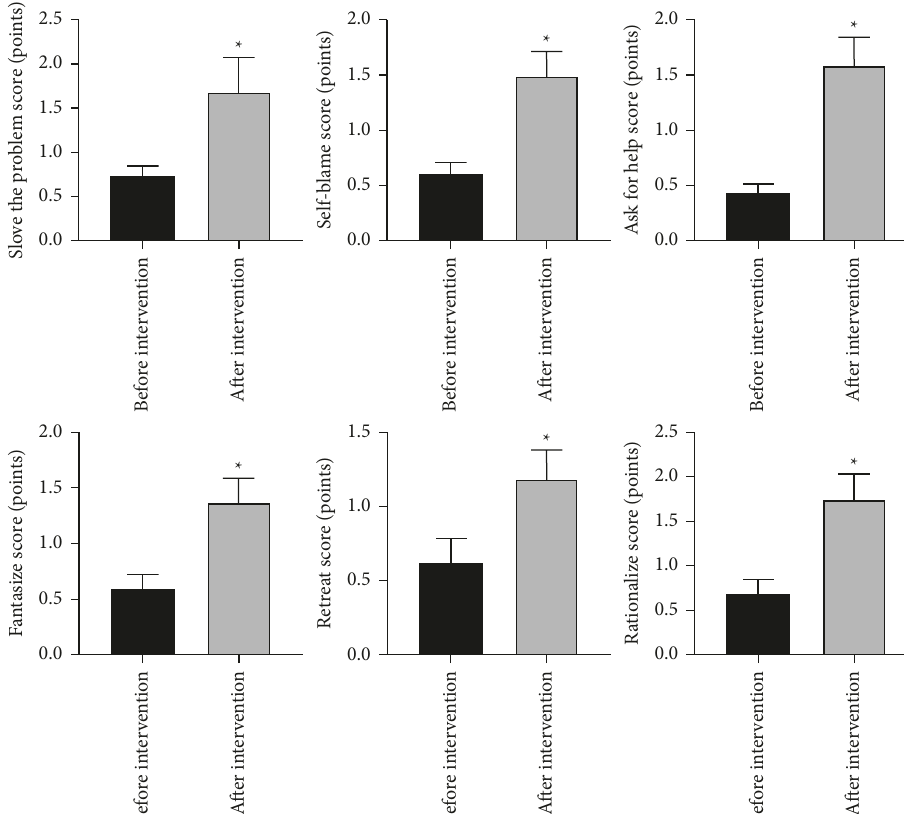
Figure 3: Comparison of stress response before and after intervention compared with before intervention, ∗ P < 0 . 05. Comparison of job burnout before and after intervention.